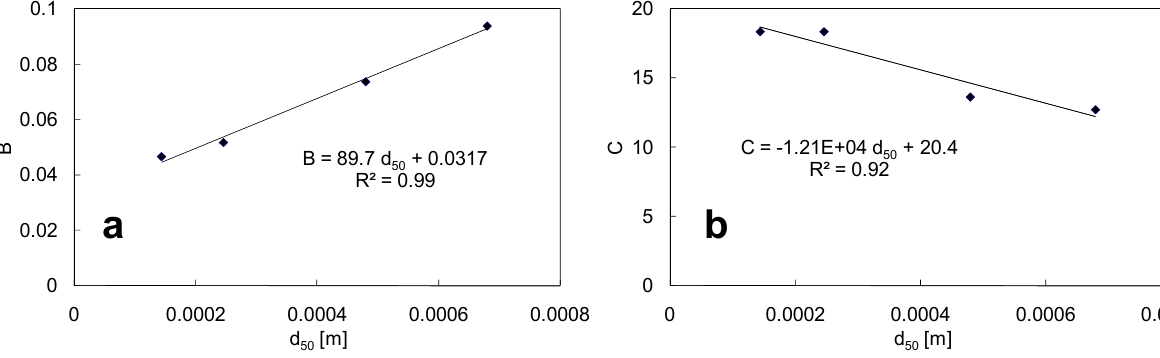
Figure 4. Relationship between (a) d